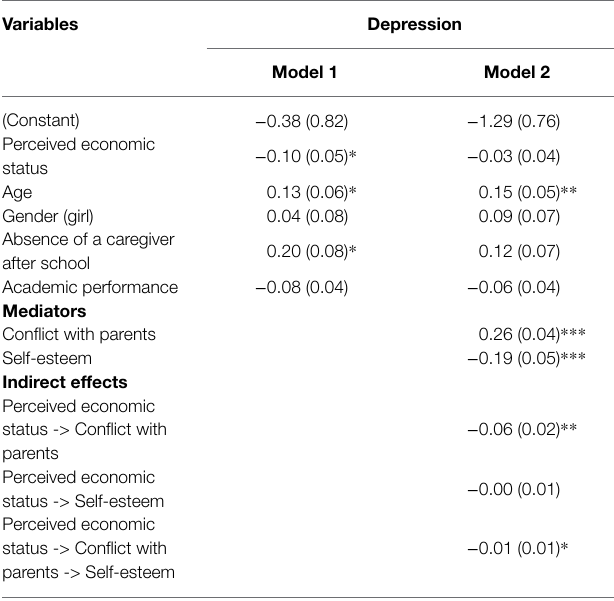
TABLE 3 | Direct and indirect effects of perceived economic status on depression using SPSS